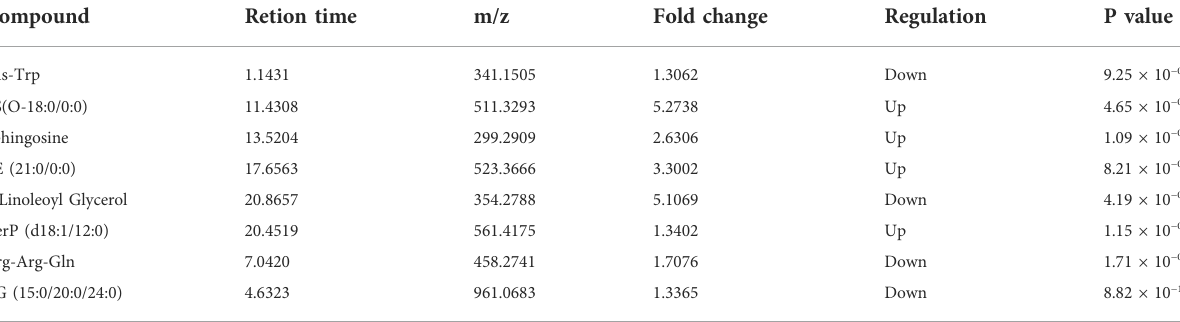
TABLE 3 The fold changes of the potential biomarkers between the patients before and after HAART treatment. Compound Fold change